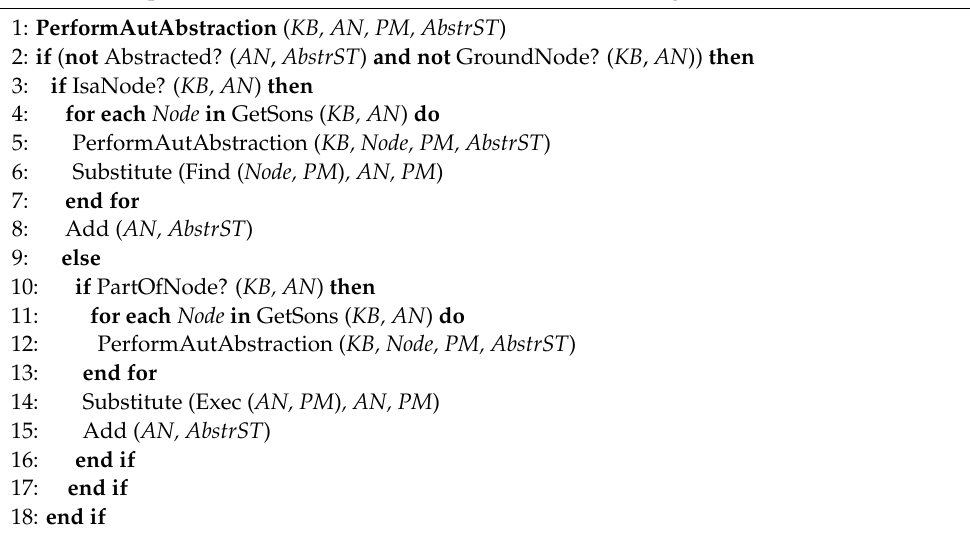
Algorithm 2: pseudocode of the recursive automatic abstraction